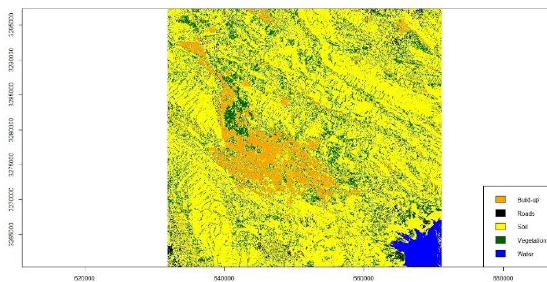
Figure 5. Image classification using Support Vector Machine classifier within R programming language.